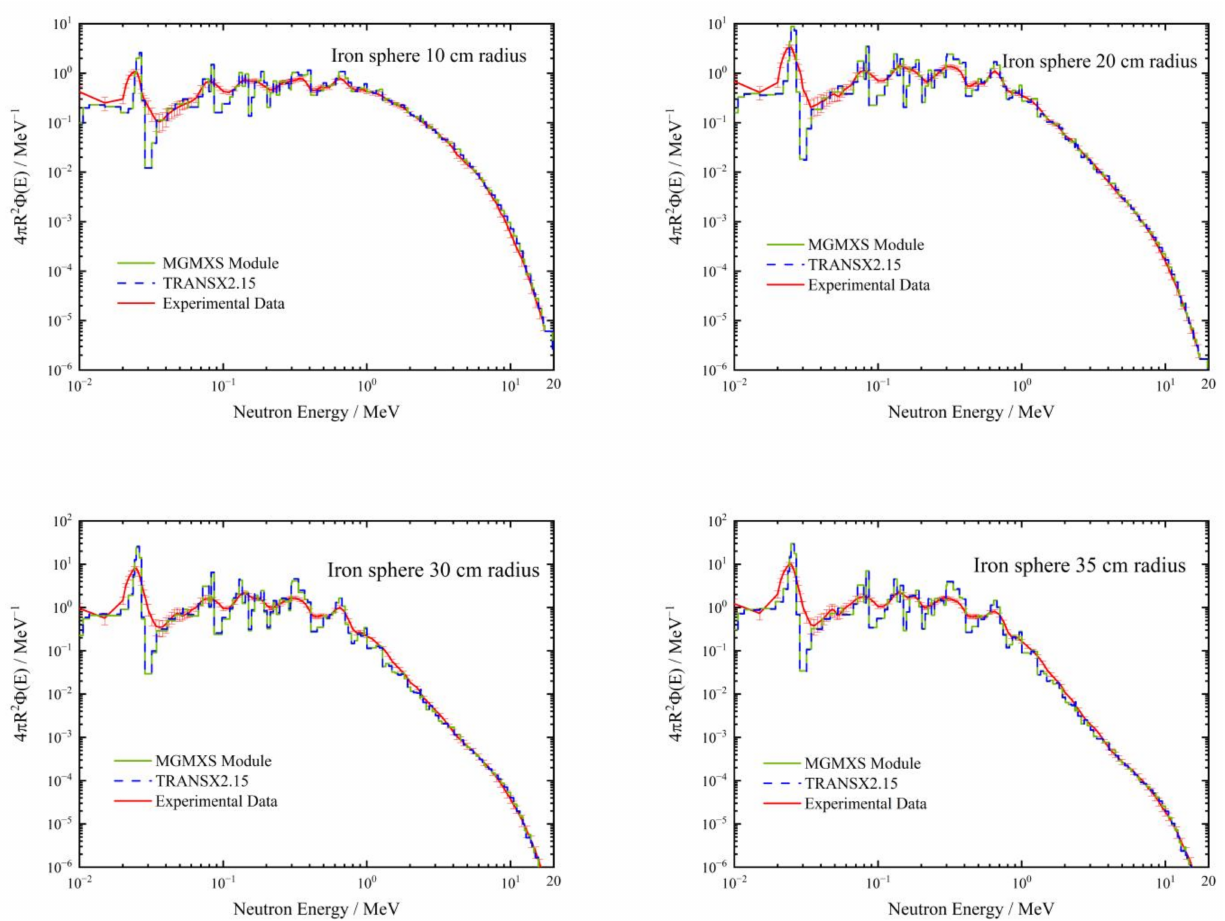
Figure 10. Comparison of experimental and calculated results of different radii of iron